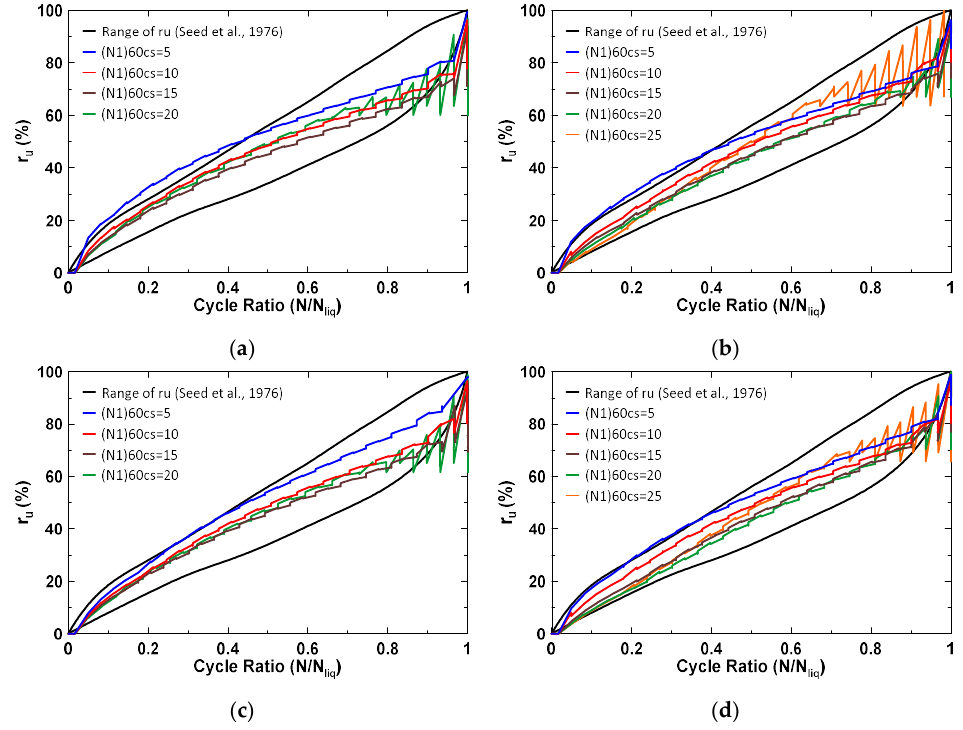
Figure 4. Accumulation of excess pore water pressure ratio and the associated cycle ratio of the Finn model. ( a ) HBF; ( b ) JRA96; ( c ) NCEER; ( d ) T-Y.